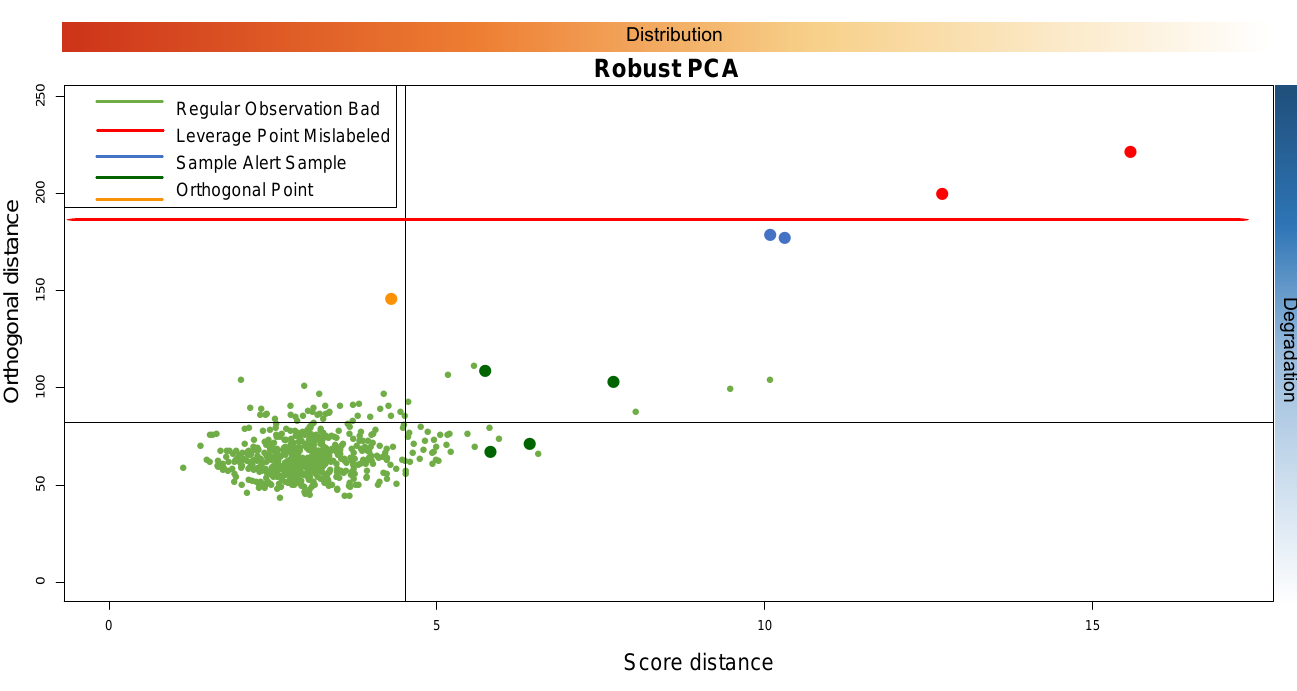
Figure 14. Pseudo-classification of the outlier